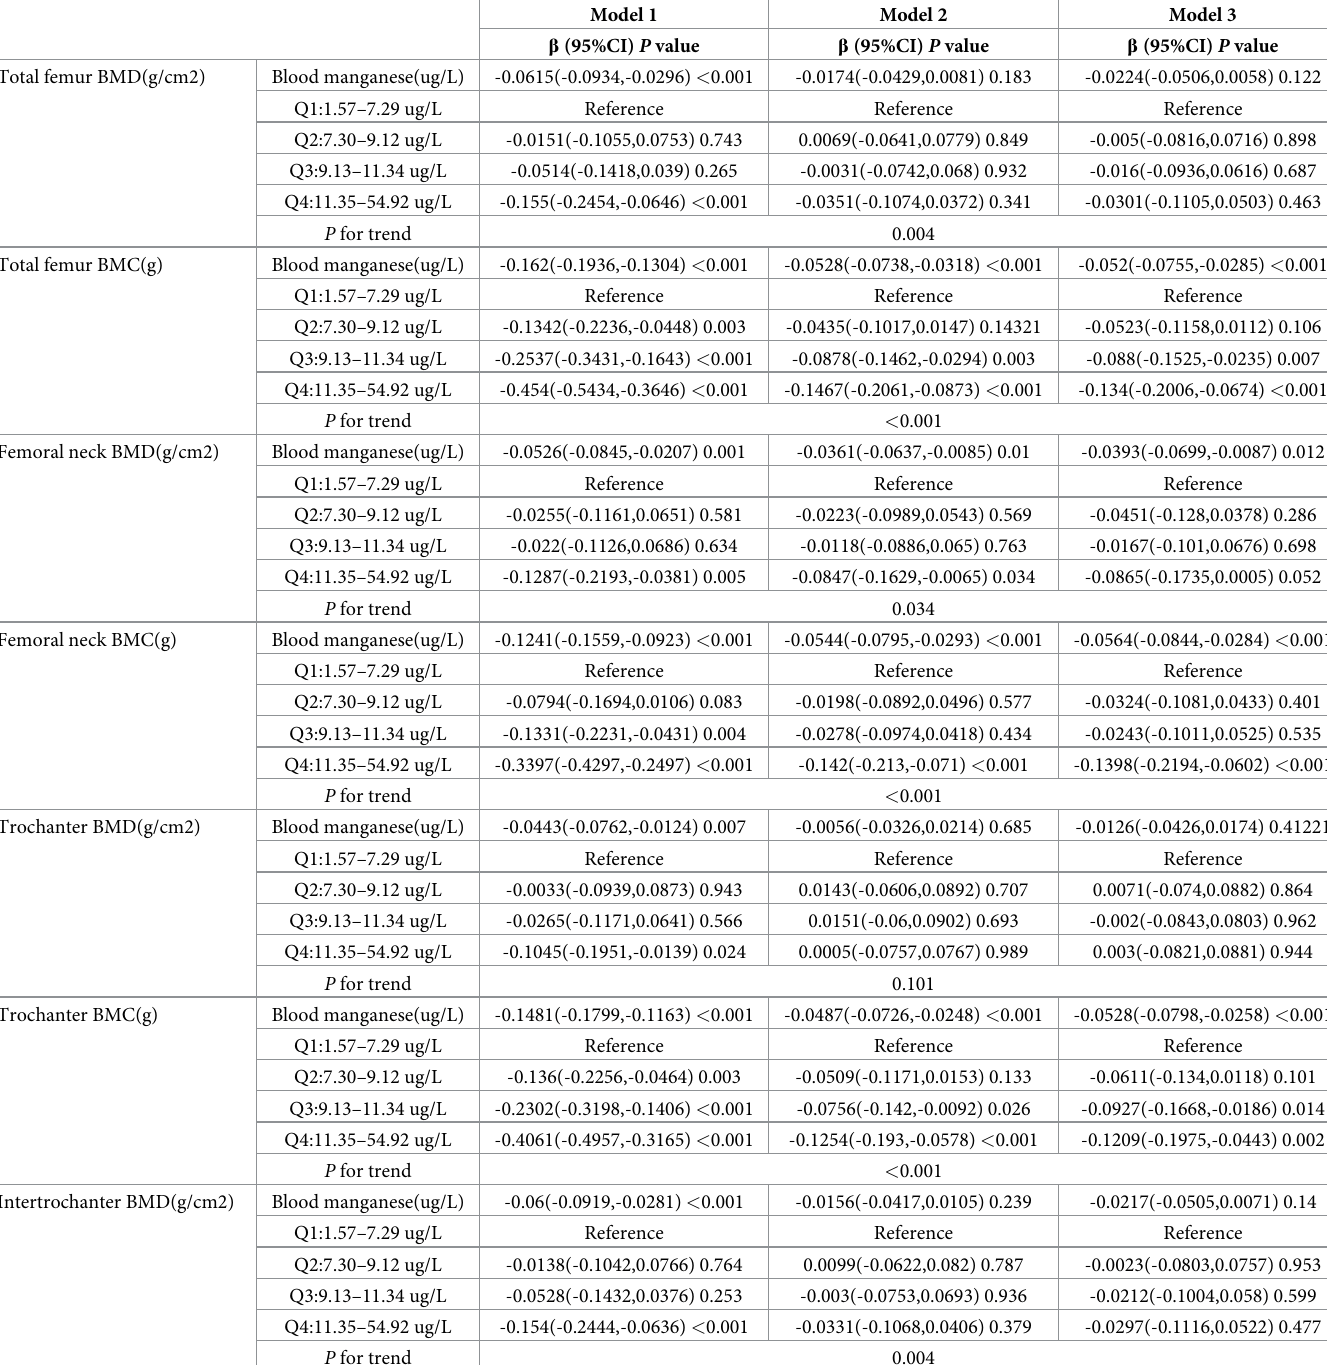
Table 1. The relationship between blood manganese and BMD/BMC in